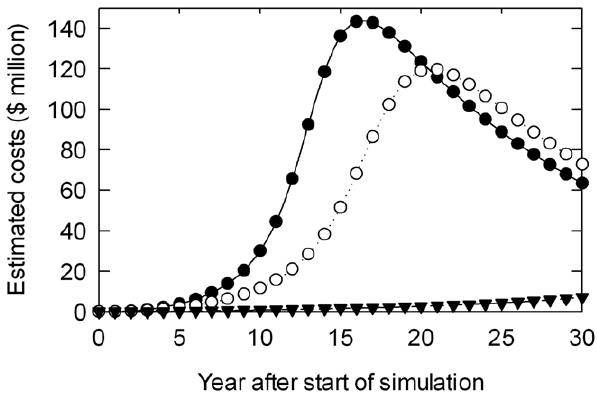
Figure 8. Variation in simulated annual costs due to Thaume- topoeapityocampa (discounted back to simulation start) under scenarios assuming no control (closed circles) little control (open circles) and good control (closed triangles). All scenarios used simulations with a median spread rate as sampled from the 50 th